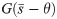
Reference measure.The function G(s¯−θ) and its exponential for JI < 0.